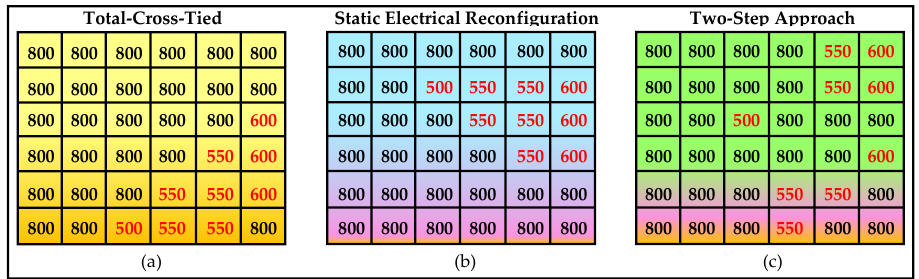
Figure 12. Graphical comparison of the two-step approach under partial shading S3. ( a ) P~V curve comparison with conventional configurations, ( b ) P~V curve comparison with hybrid configurations, ( c ) P~V curve comparison with the static reconfiguration technique, and ( d ) parameter comparison among all configurations.